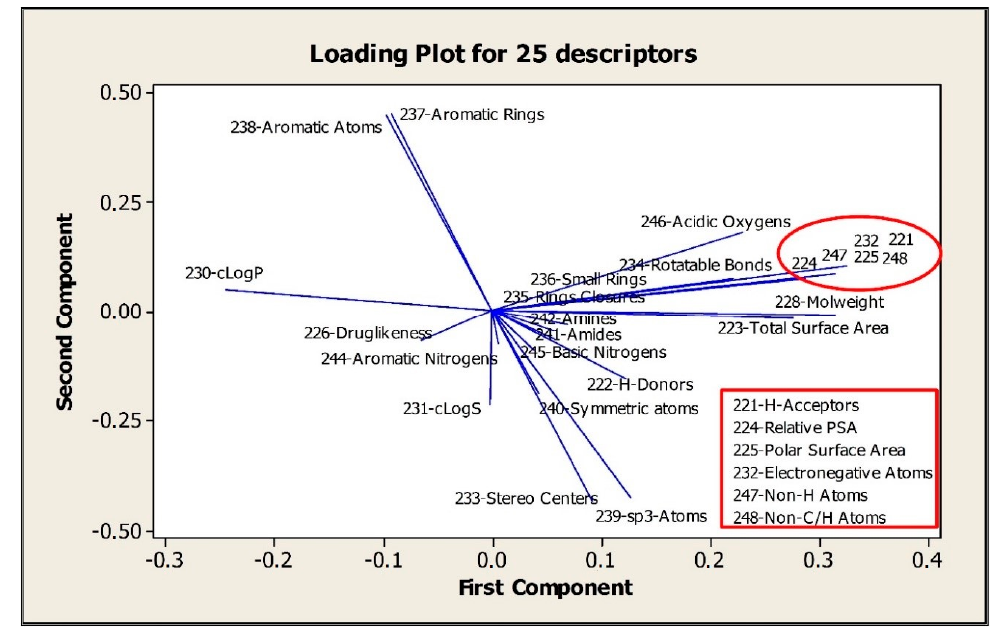
Figure 5. The loading plot for 25 drug-like descriptors.